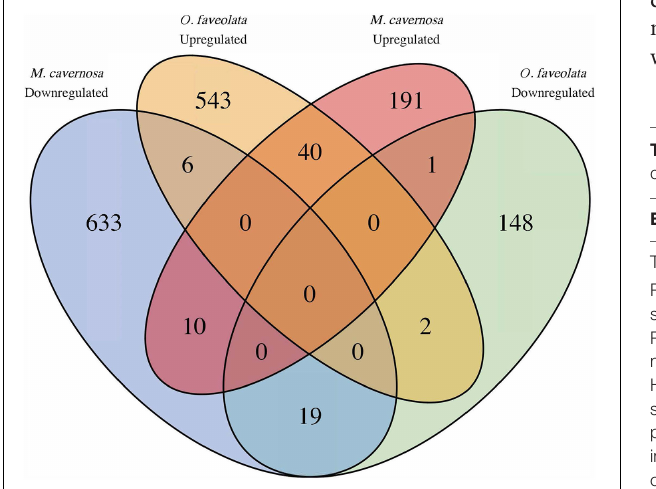
FIGURE 5 | Common differentially expressed orthogroups between diseased O. faveolata and M. cavernosa . Ortholog mapping between M. cavernosa and O. faveolata identified 70 orthofinder assigned orthogroups differentially expressed in both coral species in response to disease transmission. Of those, 59 had concordant differential expression with 40 upregulated and 19 downregulated in common. Orthogroups up and downregulated in the same species are a result of grouping closely related paralogs within an orthogroup.